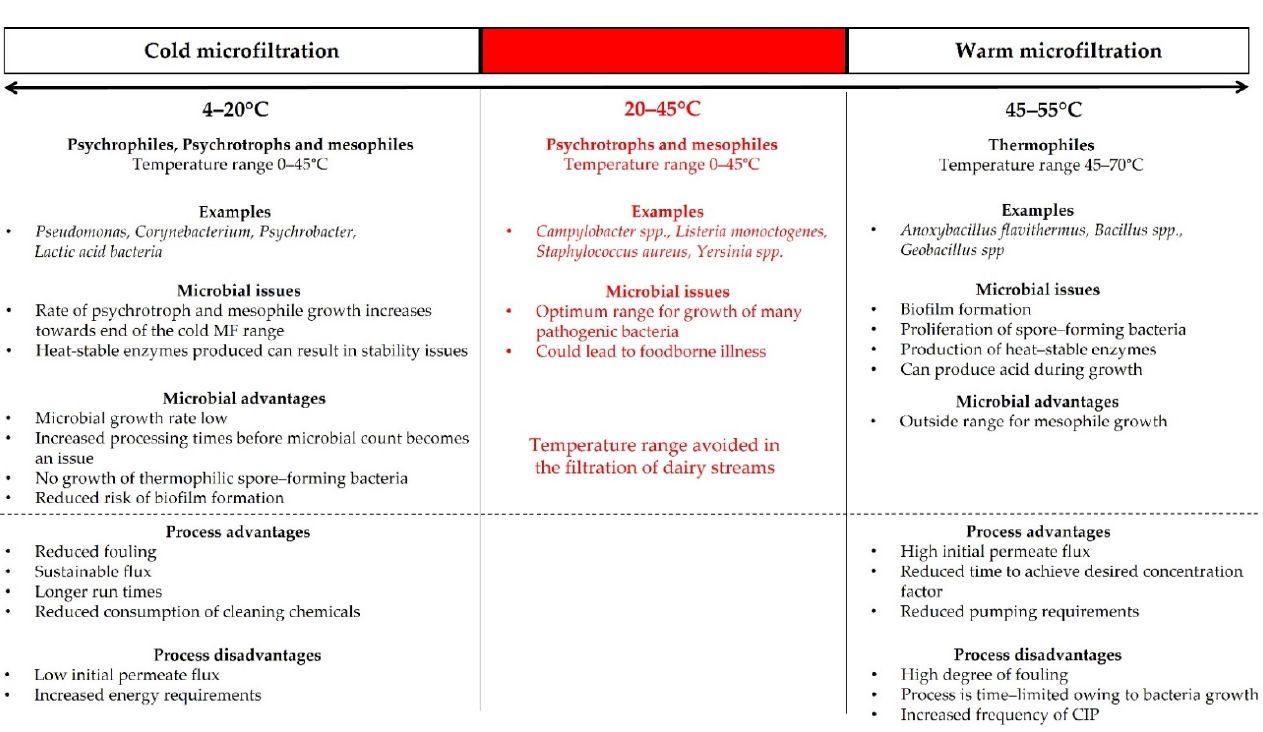
Figure 3. Schematic representation of some of the microbial considerations when selecting microfiltration processing temperature and the implications of such processing temperatures for processing efficiency and finished product quality. Information regarding examples of bacteria species sourced from [36–39].